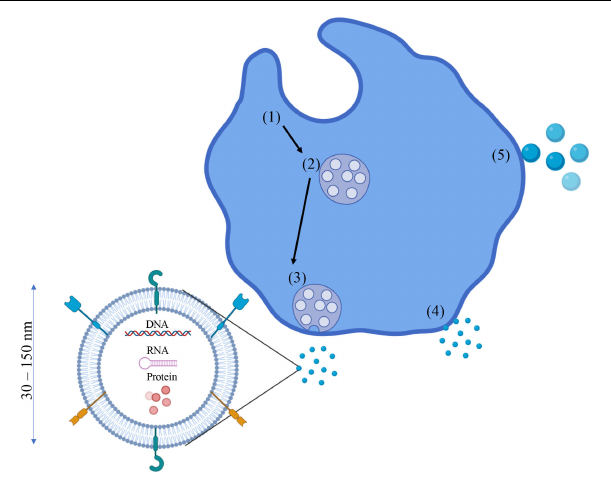
FIGURE 1 | Exosomes: Formation, cargo, and characteristics. Exosome formation typically begins as endosomes (1) begin to bud inward and form multi-vesicular bodies (MVBs) (2). These MVBs then fuse with the plasma membrane (3) and release the exosomes into the intracellular space. However, the plasma membrane can also bleb off small EVs 30–150 nm in diameter which also fall in the same size classification as exosomes, so differentiating the two can be difficult (4). If these plasma membrane blebs are > 150 nm in diameter, they are classified as microvesicles or microparticles (5). Exosomes can contain a number of different molecules as cargo such as proteins/ cytokines (free floating and membrane bound), DNA, RNA, and other nucleic